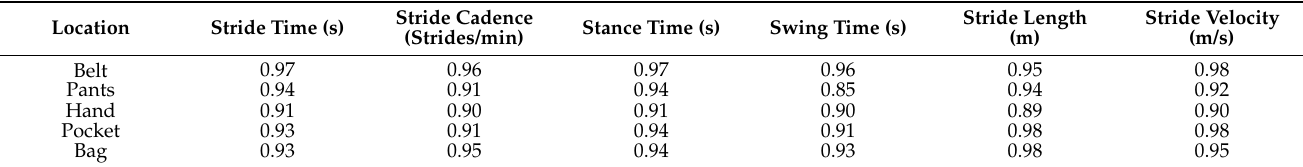
Figure 1. ICC values for relative reliability. The dotted line indicates the 0.75 threshold for excellent agreement. Table 3. ICC values for relative